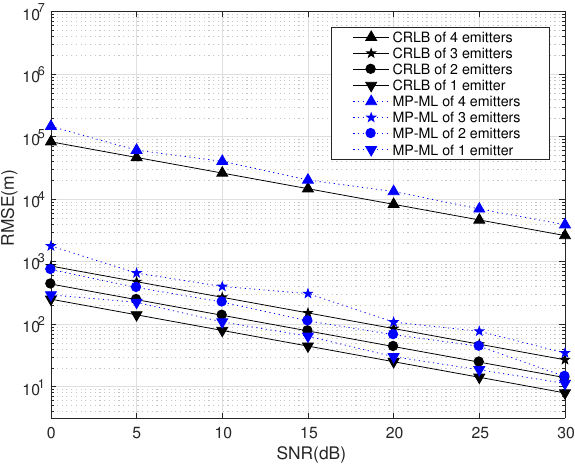
Figure 16. MP-ML and CRLB of different numbers of emitters ( K = 1024, J =